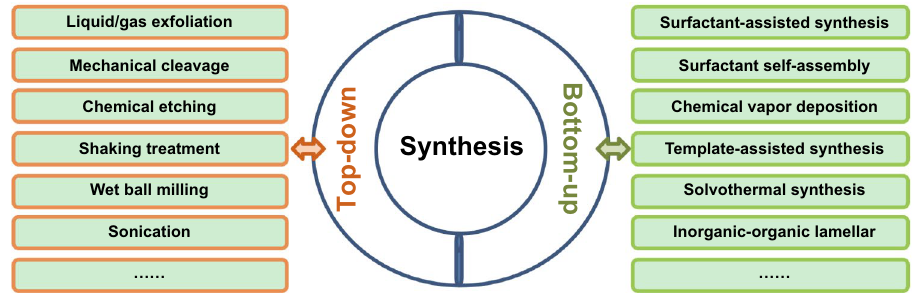
Fig. 5 Common synthesis procedures for 2D nanomaterial based on top-down and bottom-up methods. Top-down methods include liquid/ gas exfoliation, mechanical cleavage, chemical etching, shaking treatment, wet ball milling, and sonication. Bottom-up approaches include surfactant-assisted synthesis, surfactant self-assembly, chemical vapor deposition, template-assisted synthesis, solvothermal synthesis and inor- ganic–organic